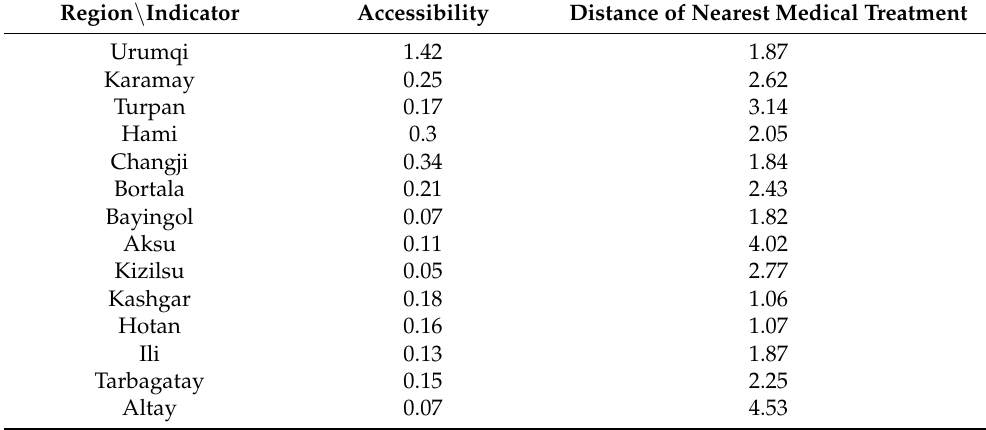
Table A4. Indicator of equalization of basic medical services and convenience of medical treatment in all